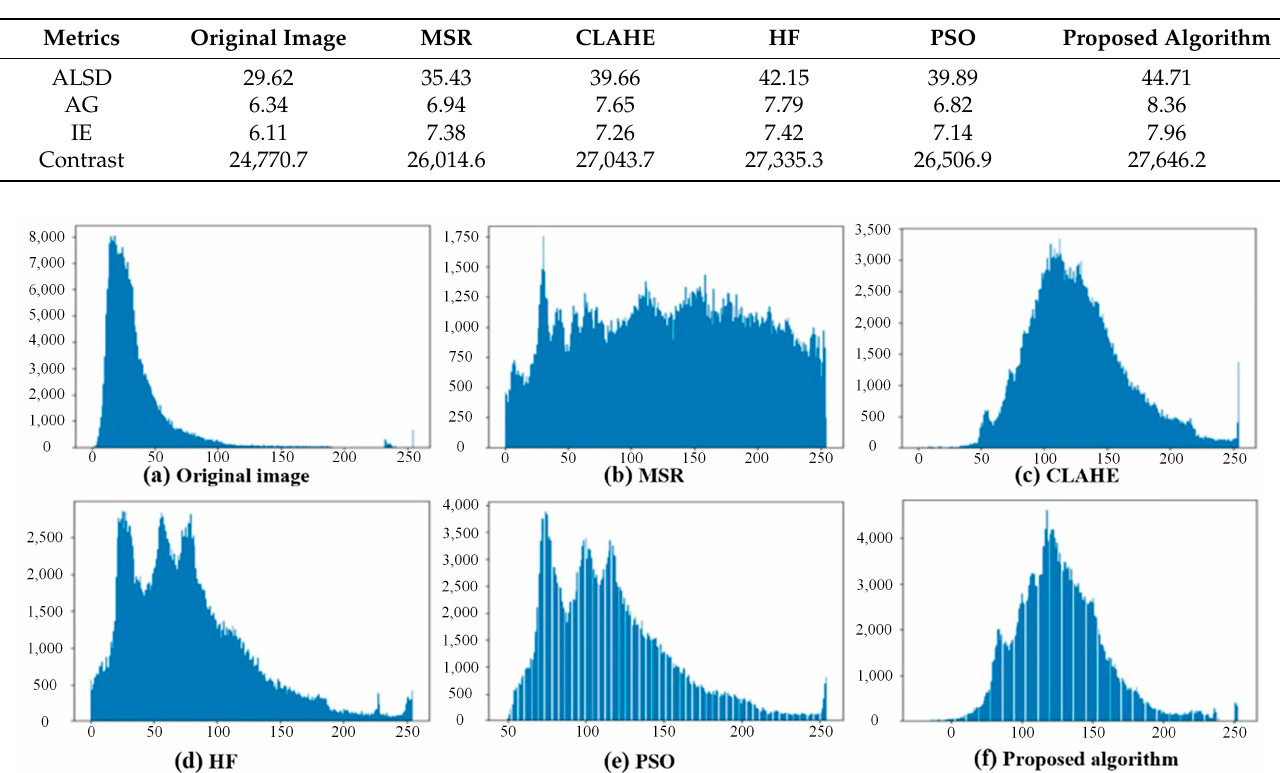
Table 2. Comparison of mine image enhancement algorithms.